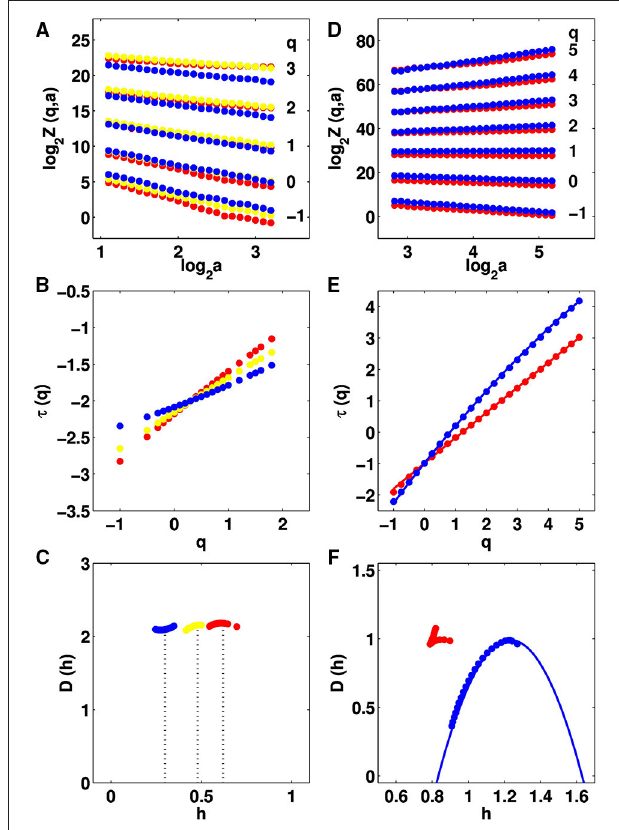
FIGURE 2 | Multifractal analysis of IR temperature time series and X-ray mammograms of patient 20. Comparative analysis of spatial roughness fluctuations in individual 256 × 256 pixel 2 squares in the cancerous right breast with respectively monofractal H < 0.45 (blue), 0.45 ≤ H ≤ 0.55 (yellow) and H > 0.55 (red): (A) log 2 Z ( q , a ) vs. log 2 a ; (B) τ ( q ) vs. q estimated by linear regression fit of log 2 Z ( q , a ) vs. log 2 a (Equation 6) over a range of space-scales [0.7 ; 2.8] mm; (C) D ( h ) vs. h . Comparative analysis of temperature fluctuations in a 8 × 8 pixel 2 square in the cancerous right breast (monofractal c 2 < 0.03, red) and contralateral unaffected left breast (multifractal c 2 ≥ 0.03, blue): (D–F) as (A–C) .